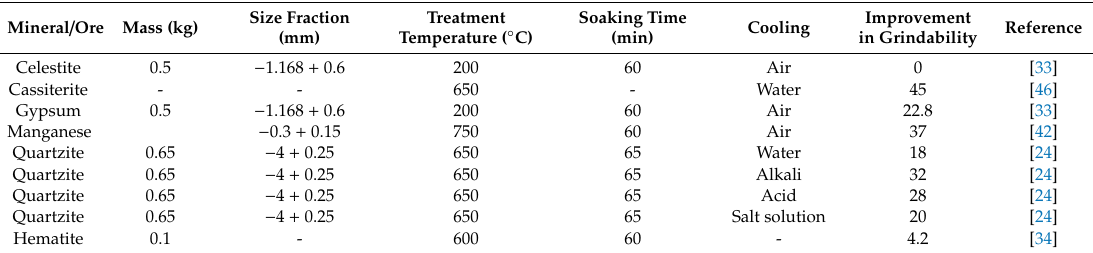
Table 1. Summary of thermal pretreatment via furnace on the grindability of minerals / ores. Improvement Size Fraction Treatment Soaking Time Reference Cooling Mineral / Ore Mass (kg) (mm) Temperature ( ◦ C) (min) in Grindability Celestite 0.5 − 1.168 + 0.6 200 60 Air 0 [33] Cassiterite - - 650 - Water 45 [46] Gypsum 0.5 − 1.168 + 0.6 0.65 − 4 +